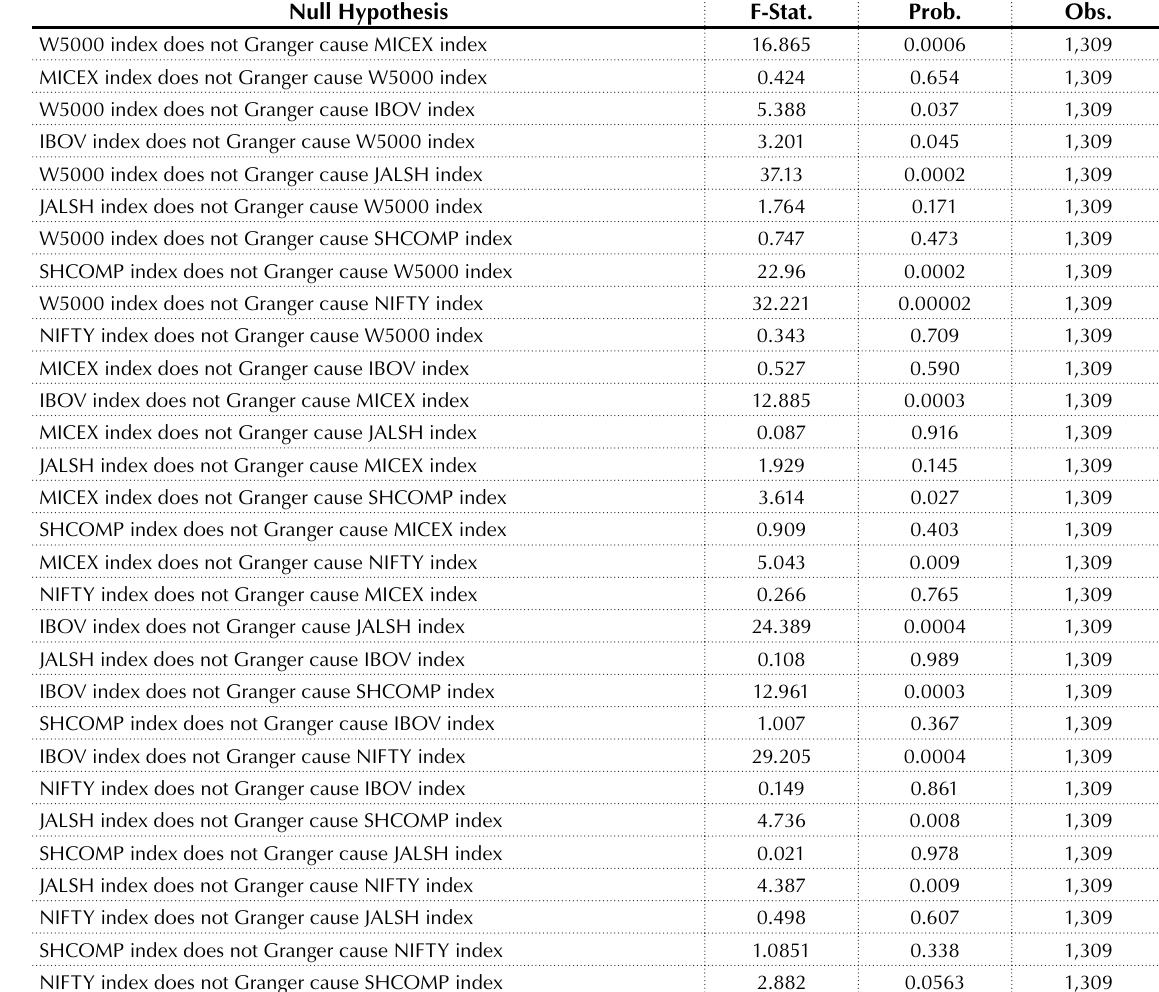
Table 5. Pairwise Granger causality